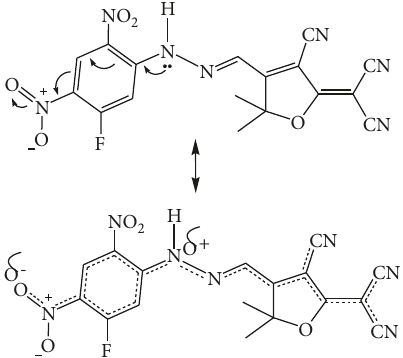
Scheme 2: An extended inductive effect afforded a semi-donor-acceptor molecular system.